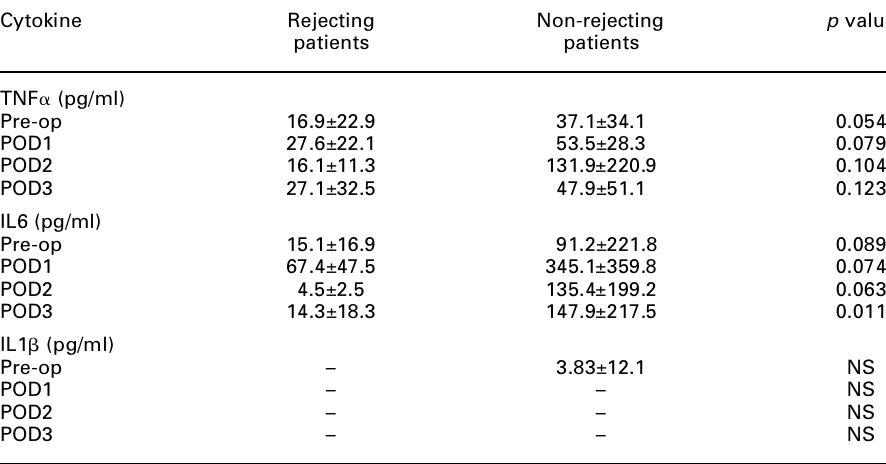
Table 3. Release of pro-inflammatory cytokines during the early postoperative period Cytokine Rejecting